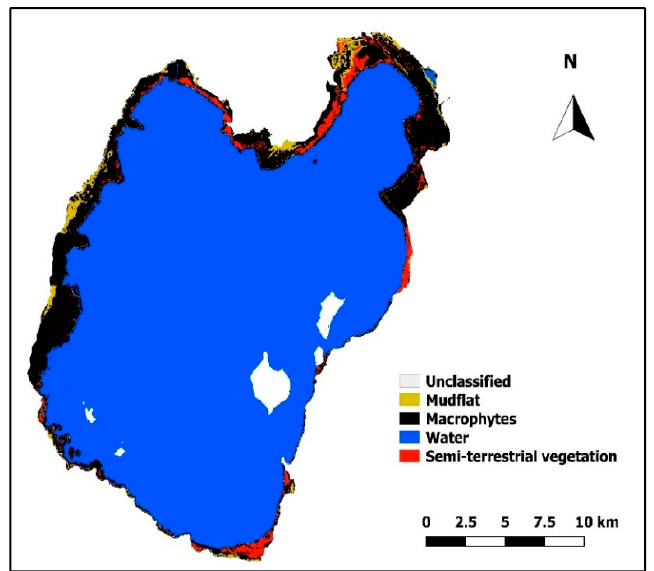
Figure 8. Distribution of four major target classes (NDAVI based classification) generated using Landsat 8 OLI image from October 2016.